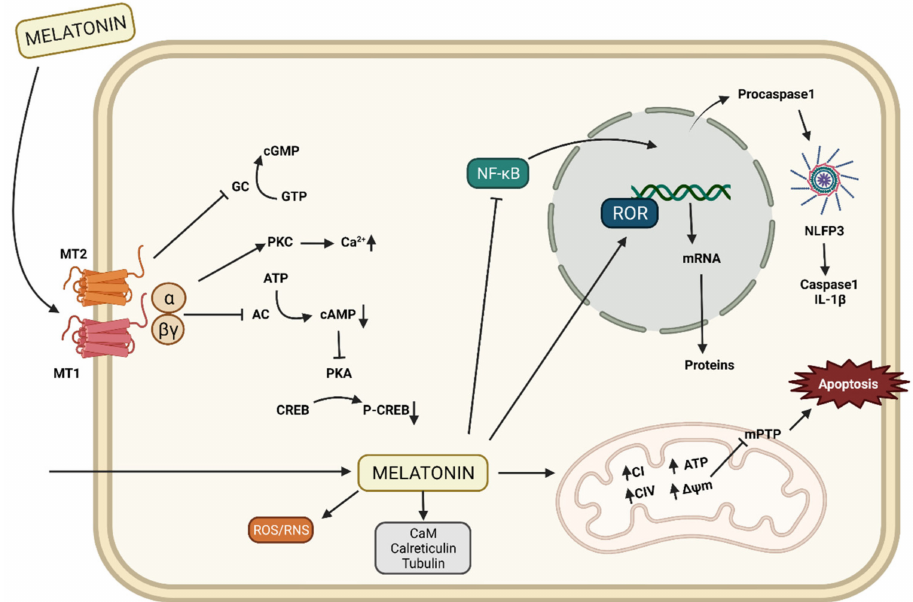
Figure 3. Mechanism of action of melatonin. Melatonin has 2 membrane receptors, MT1 and MT2, coupled to G proteins. Through them it inhibits cAMP and cGMP levels, CREB phosphorylation, and increases calcium levels. It also has nuclear receptors, ROR, through which it regulates gene transcription. In addition, melatonin into the cell interacts with molecules such as calmodulin, calreticulin, and tubulin, and scavenges ROS/RNS. It also inhibits the translocation of NF-kB to the nucleus where it promotes the release of procaspase 1 to the cytosol, preventing the formation of the NLRP3 inflammasome and activation of caspase 1 and IL-1 β . Finally, melatonin maintains mitochondrial homeostasis, increasing the activity of the respiratory complexes I, III, and IV, ATP production, reducing membrane potential and thus closing the mTP preventing